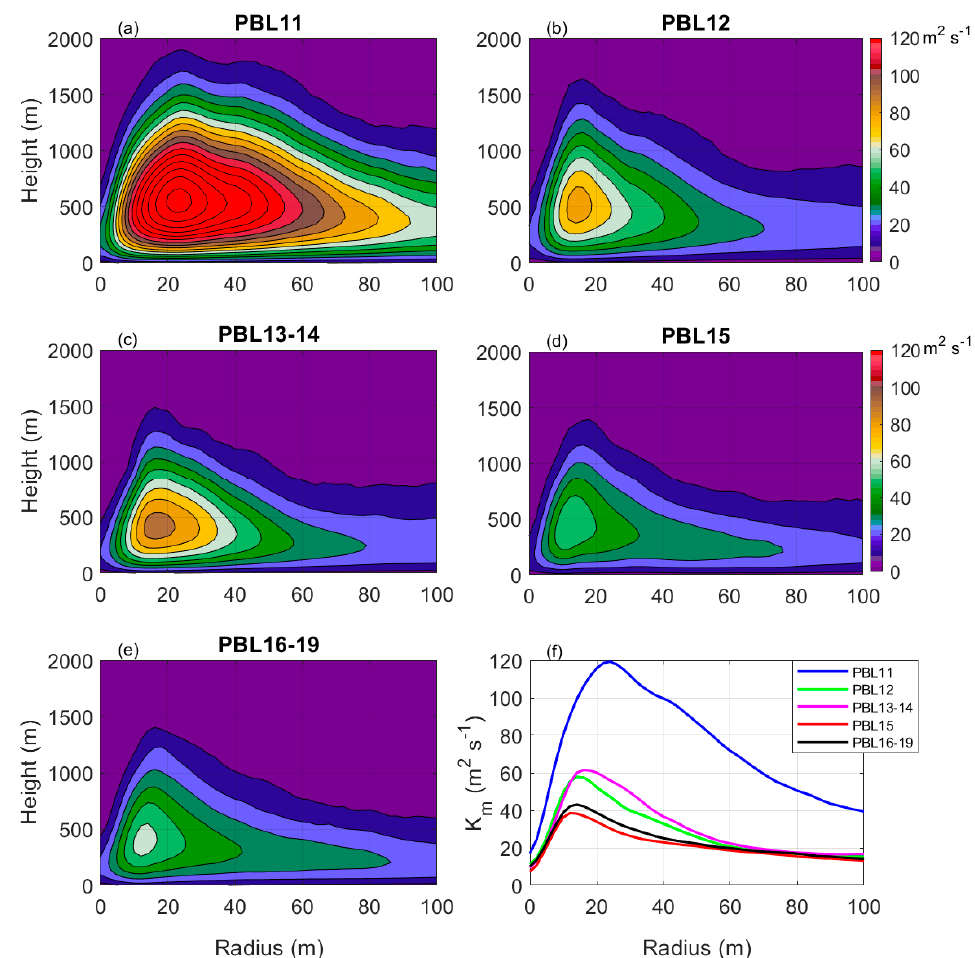
Figure 1. Radius-height plots of the azimuthally averaged vertical eddy di ff usivity ( < K m > ) during the rapid intensification (RI) period (t = 12–30 h) in the idealized HWRF simulations with ( a ) PBL11, ( b ) PBL12, ( c ) PBL13–14, ( d ) PBL15, and ( e ) PBL16–19 schemes. Radial profiles of K m averaged within the lowest 1 km layer during the RI period are shown in ( f ). The contour interval in ( a – e ) is 10 m 2 s − 1 .